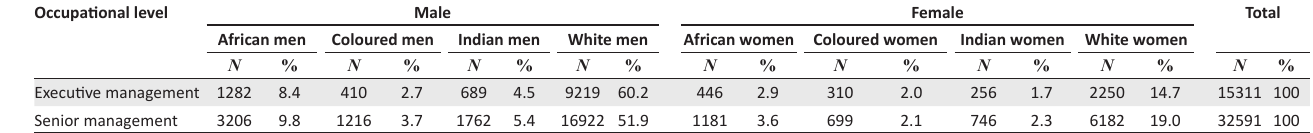
TABLE 2: Total number of employees by occupational level, race and gender at executive and senior management level. Occupational level Male African men